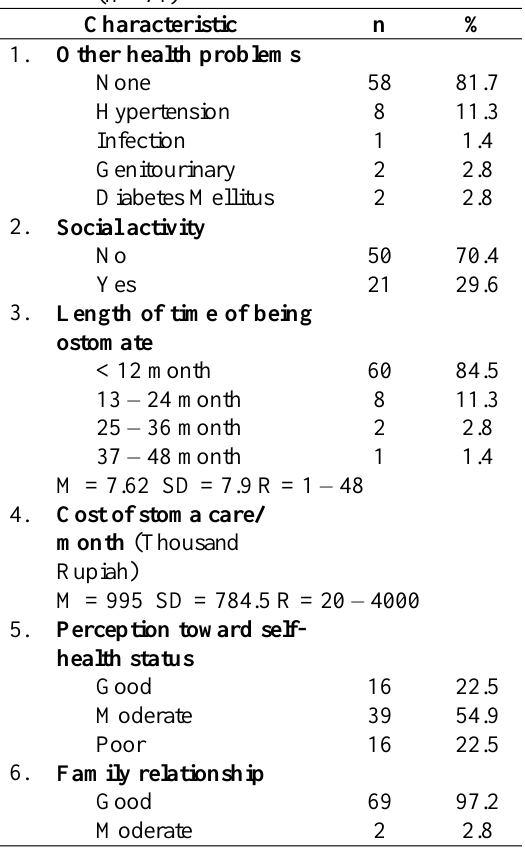
Table 2. Health characteristics of the respondents (n = 71) Characteristic